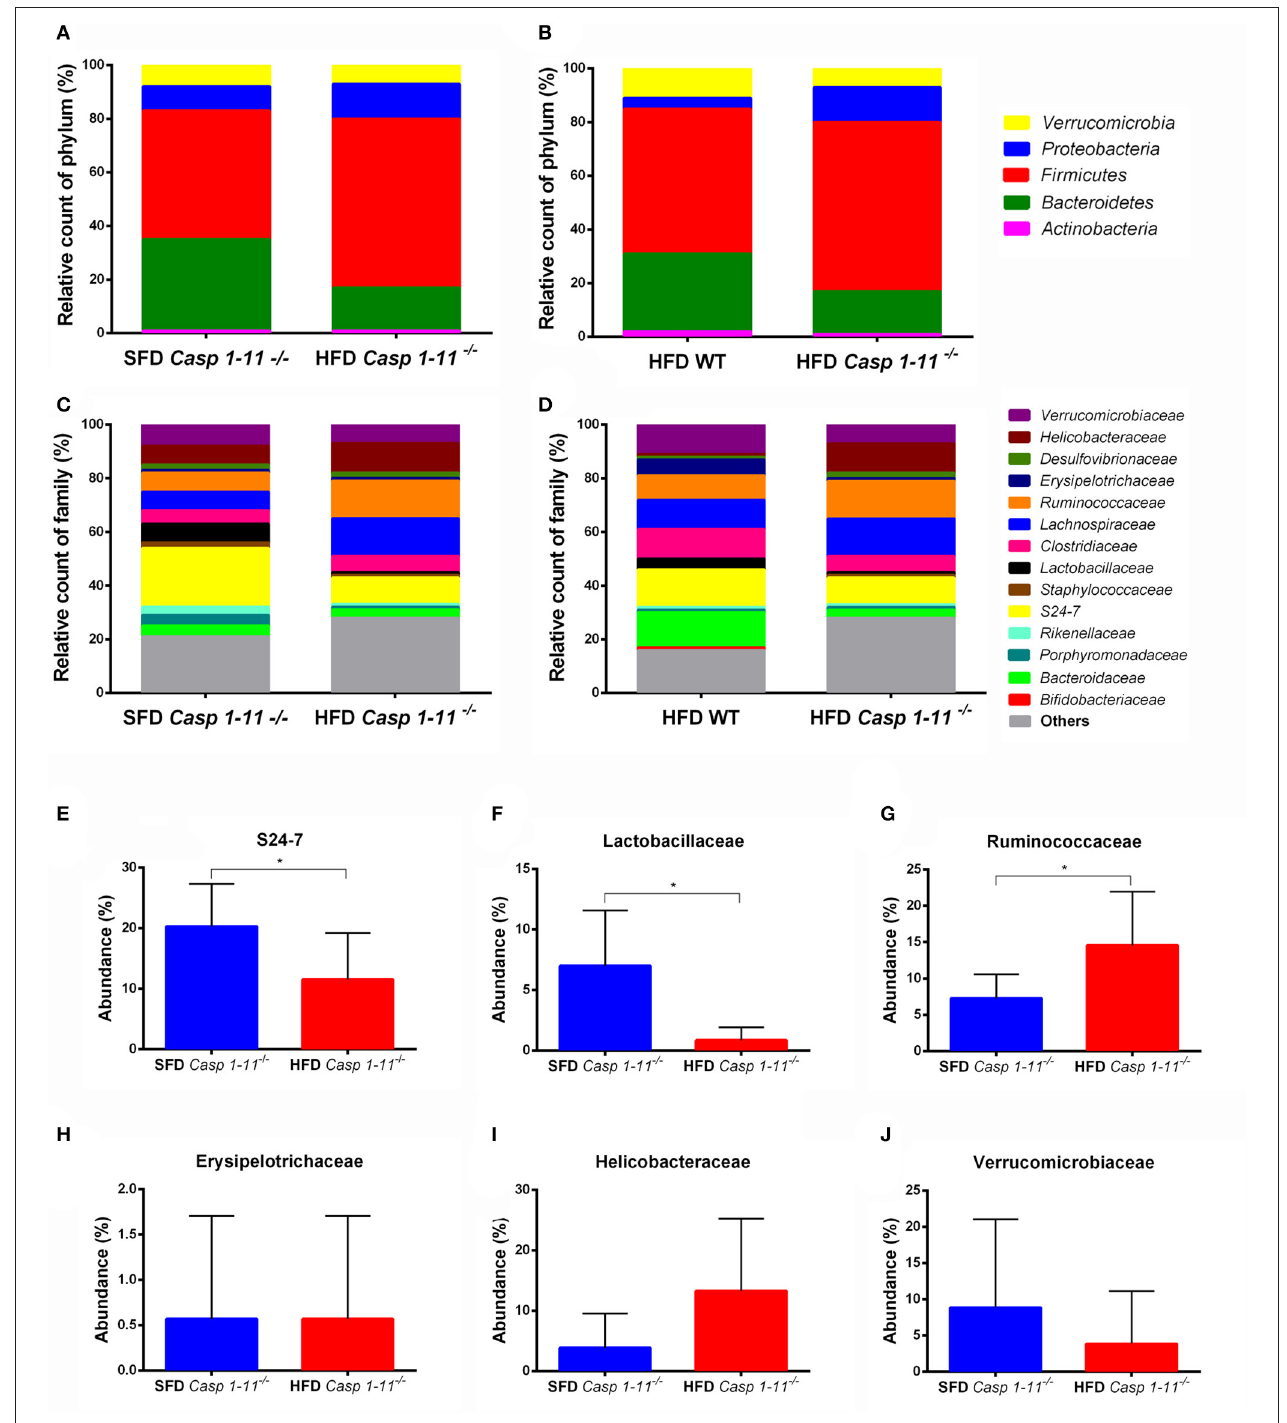
FIGURE 5 | Taxonomic analysis of the gut microbiota. WT and caspase-1/11 − / − mice were fed a SFD (17% fat) or a HFD (45% fat) for 90 days. Feces from all groups were collected and 16S rRNA gene sequencing of the V4 region was performed on the Illumina HiSeq platform to characterize the distal gut microbiota. Bar charts represent the relative abundance of bacterial (A,B) phyla and (C,D) families in all mice according to their diet and genotype ( n = 481 samples). Differences in the abundance of a subset of bacterial families related to NAFLD found in the gut of Caspases 1-11 − / − mice, according to their diet (E–J) . Significance was obtained with a t test for each bacterial taxa, the bars represent confidence interval of 95% (* p < 0.05).